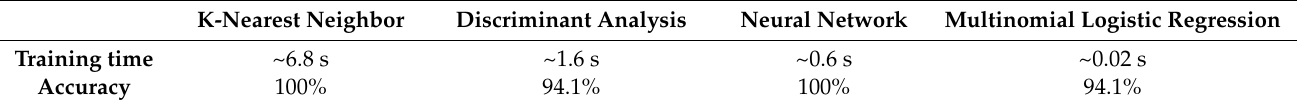
Table 1. Comparison of the